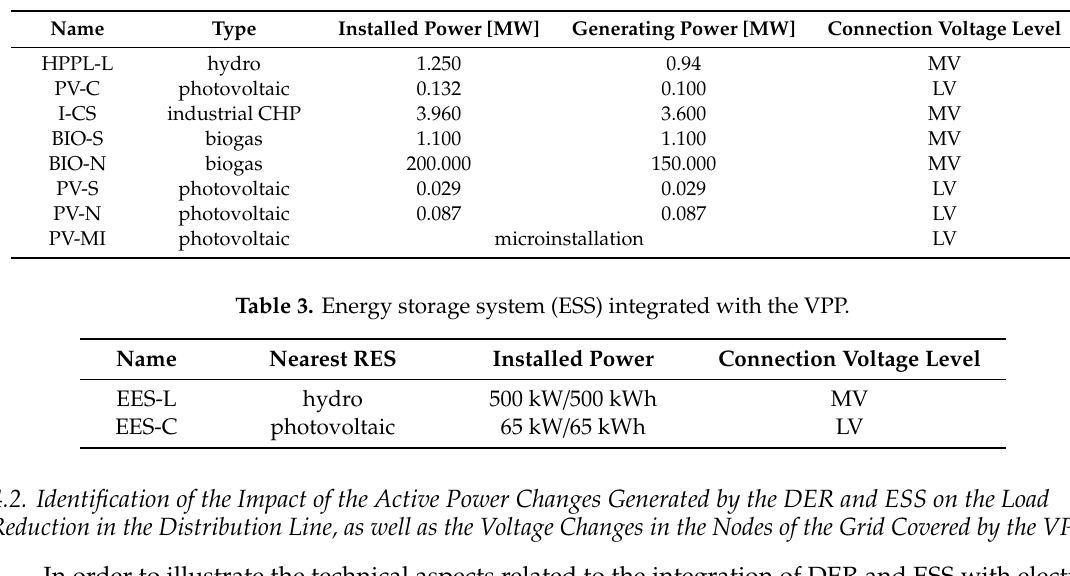
Figure 4. Topology of the planned virtual power plant (VPP). Table 2. Renewable source of energy (RES) in the area of the planned VPP.